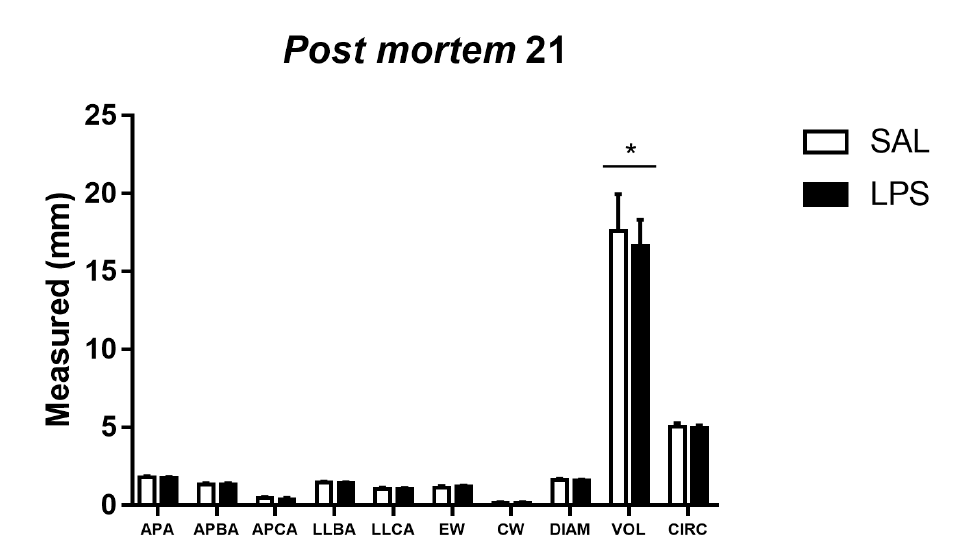
Figure 10. Effects of prenatal exposure to lipopolysaccharide (LPS), compared to the control group (SAL), on the development of rats: post mortem brain (n=24). The evaluation was performed on the 21st postnatal day. Data presented on average ± S.D. *p < 0.05. APEA = anterior-posterior encephalium axis; APBA = anterior-posterior brain axis; APCA = anterior-posterior cerebellum axis; LLBA = laterolateral axis of the brain; LLCA = laterolateral axis of the cerebellum; EW = encephalic weight; CW = cerebellum weight; DIAM = diameter; VOL = volume; CIRC =